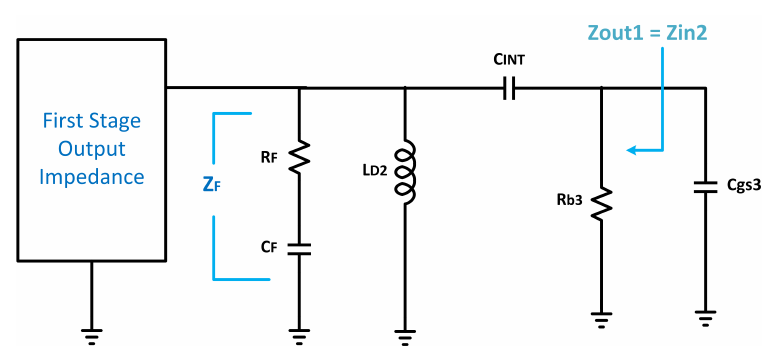
Figure 6. Interstage impedance matching network transform equivalent